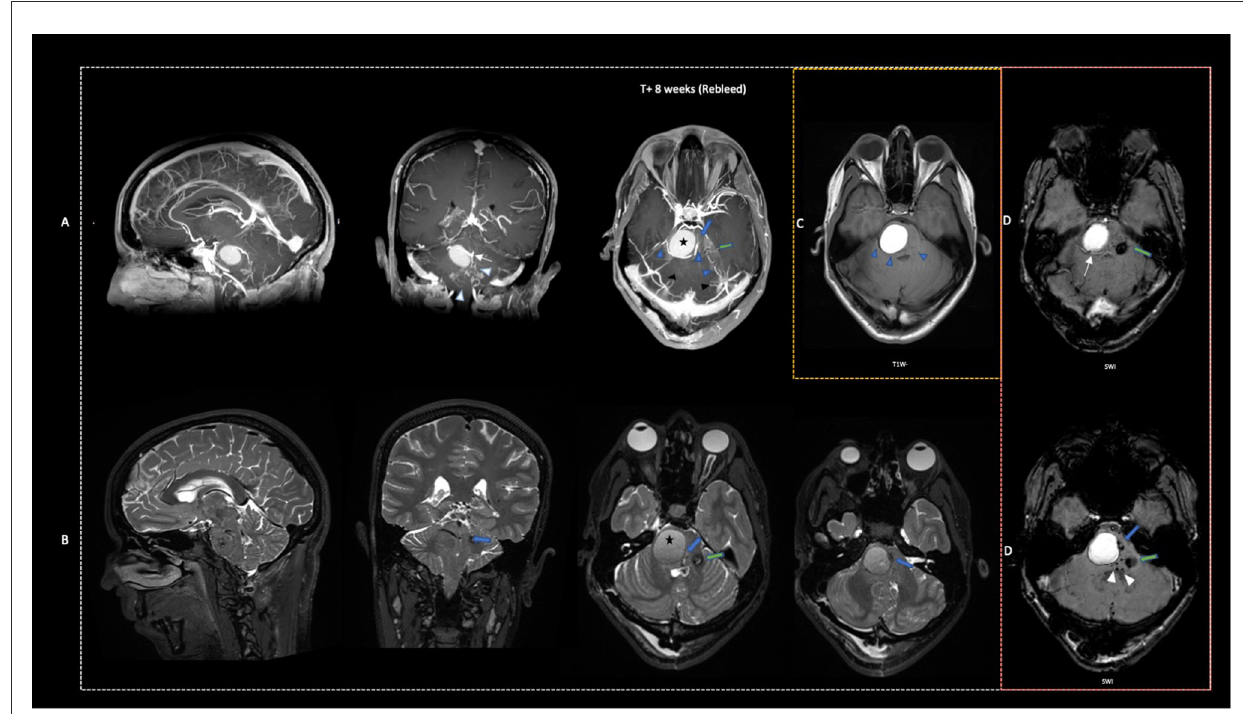
FIGURE3 Rebleed after the first surgery. Sagittal, coronal, and axial MRI: (A) T1W + Gad; (B) T2W; axial only: (C) TW1 and (D) SWI. Showing late-stage subacute hematoma or extracellular meth-Hb (black star) with uniform hyperintense T1W signal and iso-hyperintense T2W signal. Target CCM (blue arrow) and untreated contralateral CCM (green arrow) seen as mixed signal intensity on T2W and blooming artifacts on SWI remain. Uniform filling of the main DVA draining vein but slightly stretched over hematoma as it drains into collecting vein on T1W + (white arrow) and SWI (white arrow). Evidence of elevated pressure in the DVA system from the recurrence of prominent connecting channels (white arrowheads) on T1W + and